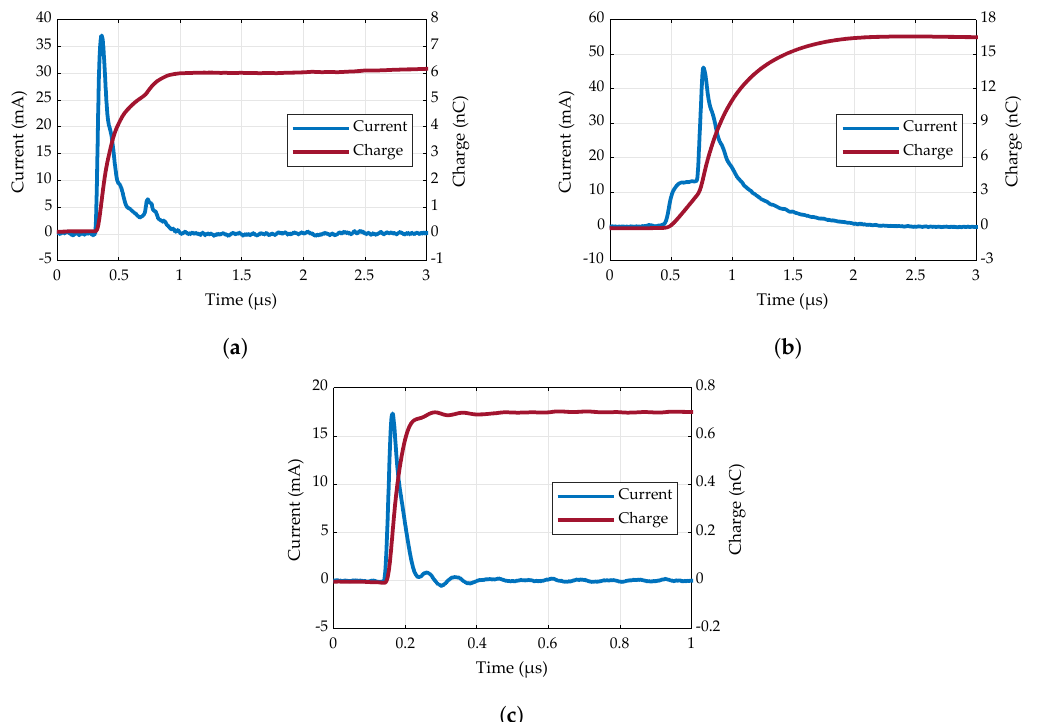
Figure 10. Positive polarity current pulses and calculated apparent charge for PTFE of 4mm thickness in: ( a ) dry air, ( b ) nitrogen (N 2 ) and ( c ) carbon dioxide (CO 2